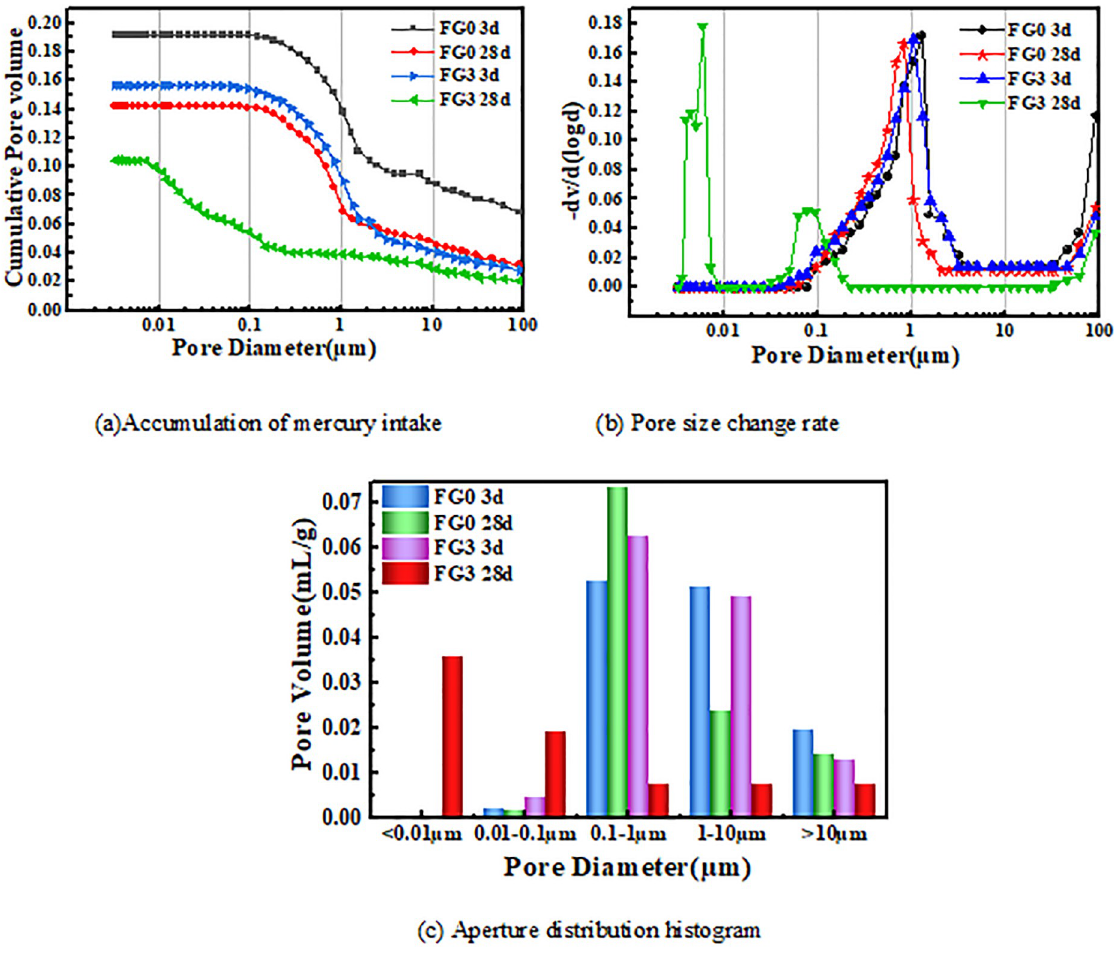
Fig 17. Aperture distribution